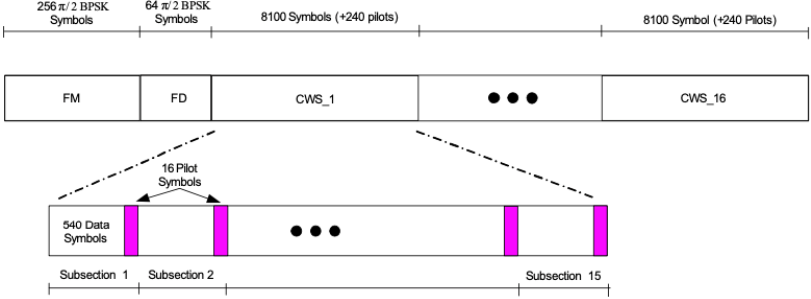
Figure 12. Physical layer frame